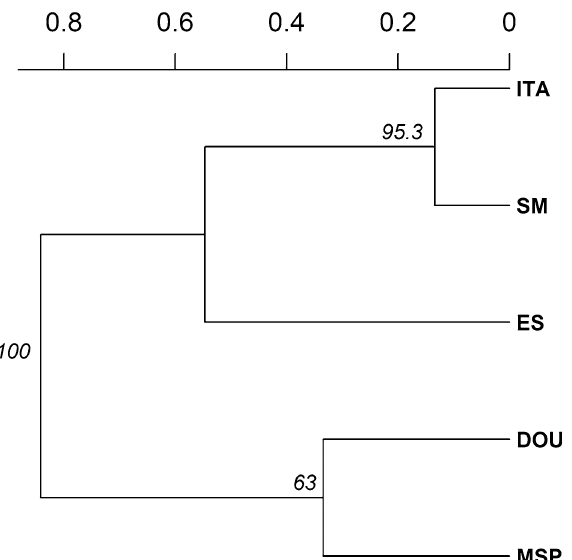
Figure 2. UPGMA based on Nei distance of seven microsatellite loci. The dendrogram represents genetic similarity among native populations of S. terebinthifolia . *ES, São Mateus-ES; SM, Santa Maria-RS; ITA,